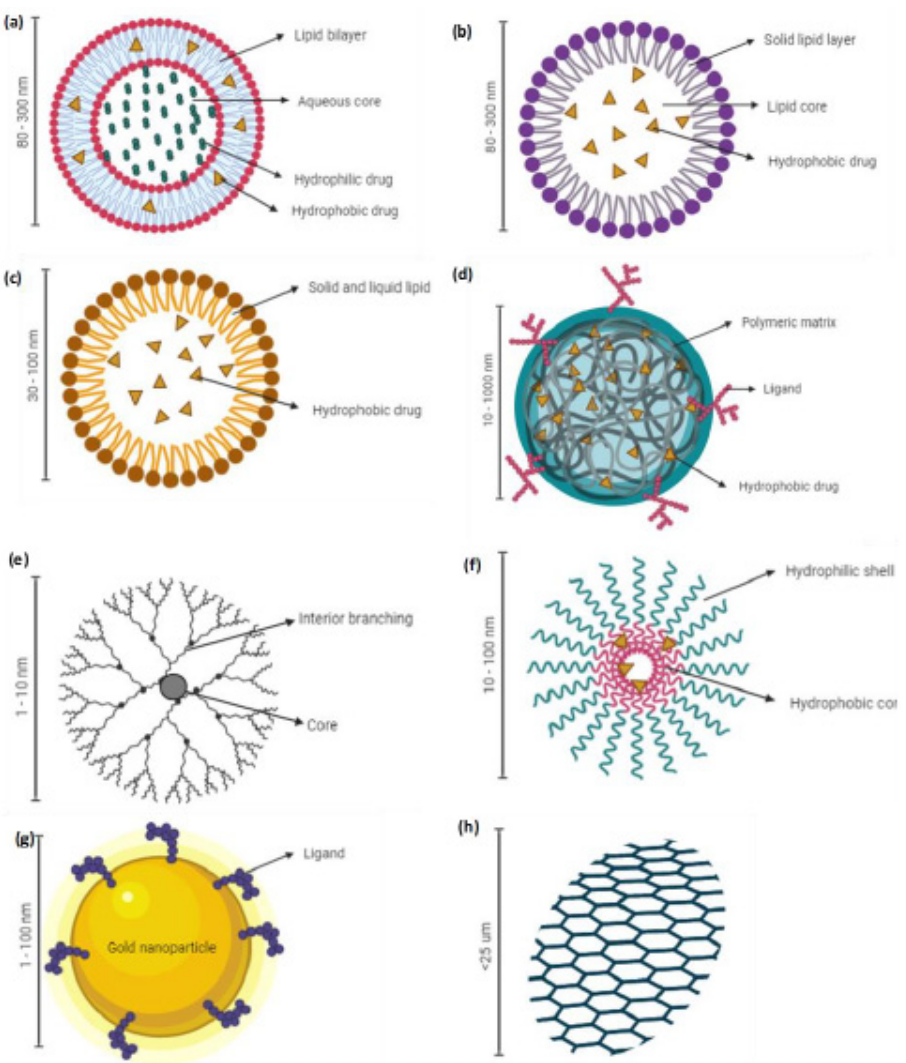
Figure 1. Schematic representation of various nanocarriers experimented for the treatment of non-small cell lung cancer with their respective particle sizes. ( a ) Nanoliposomes, ( b ) solid lipid nanoparticles, ( c ) nanostructured lipid carriers, ( d ) polymeric nanoparticles, ( e ) dendrimers, ( f ) polymeric micelles, ( g ) gold nanoparticles, and ( h ) graphene (created using BioRender.com, accessed on 2 April 2021).